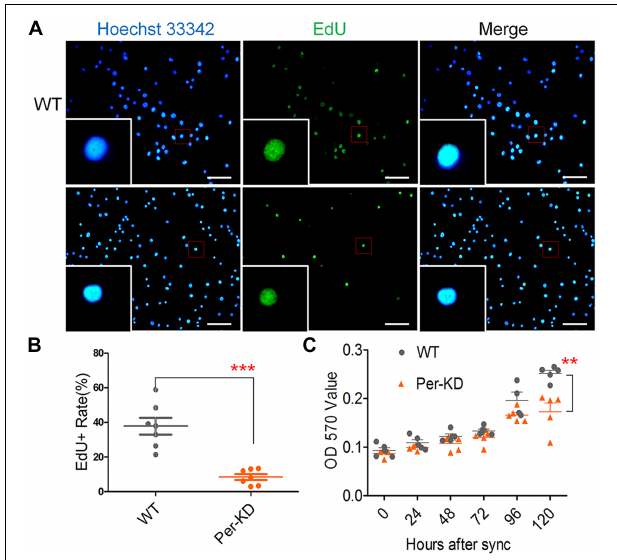
FIGURE 3 | Changes in the proliferation of Per-KD cells following inhibition of nuclear DNA synthesis. Cells were synchronized for 24 h in serum-free Grace insect medium. The medium was replaced by Grace insect medium with 10% (v/v) FBS. After 8 h incubation with EdU (A) nuclei with green fluorescence indicate DNA synthesis. All nuclei show Blue Hoechst 33342 staining. Bar = 100 µ m. (B) EdU-positive staining percentage ( n = 7). (C) After synchronization and culture in Grace insect medium with 10% (v/v) FBS, the rate of cell division was determined with an MTT assay ( n = 5). ∗∗ p < 0.01, ∗∗∗ p <